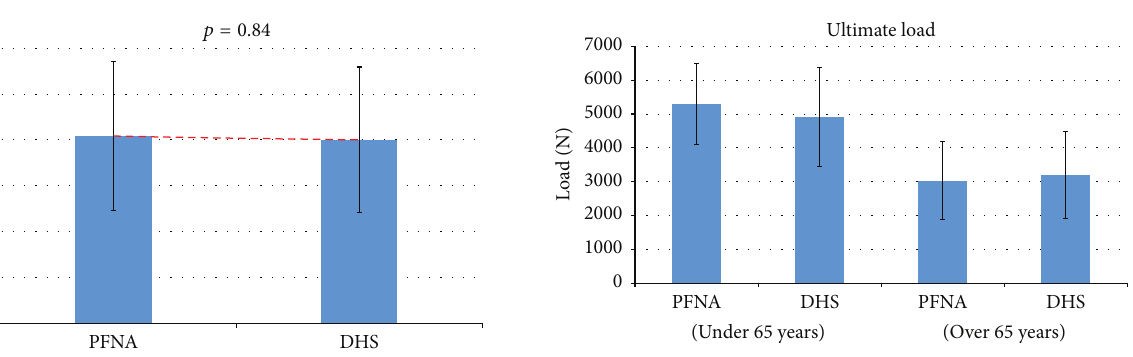
Figure 4: No difference in ultimate load between PFNA-II and DHS groups ( 𝑝 = 0.84 ).